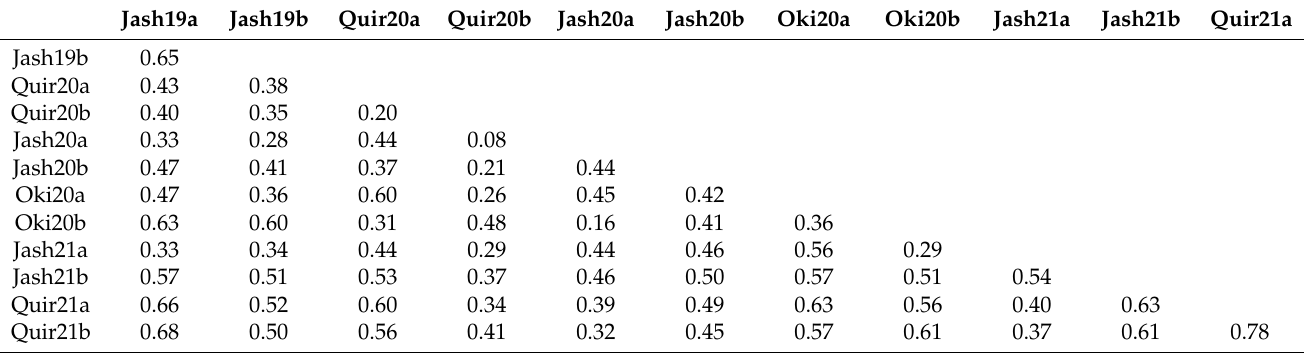
Table 2. Person correlation coefficients among 12 different environments for wheat blast